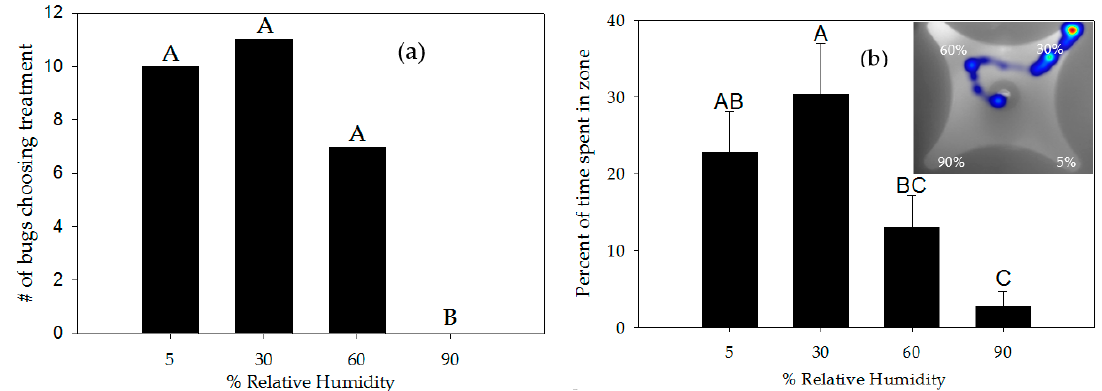
Figure 3. Responses of Triatoma rubida nymphs to different levels of relative humidity (RH). ( a ) Bugs choosing ports with airstreams carrying different levels of humidity (N = 28); ( b ) Percent of time (±SE) spent by nymphs in each zone (N = 35 bugs). Photo, the bug sampled 60% then 30% before choosing it. Within each panel, bars with the same letter are not significantly different (Ransacking analysis, Fisher’s LSD, p > 0.05).